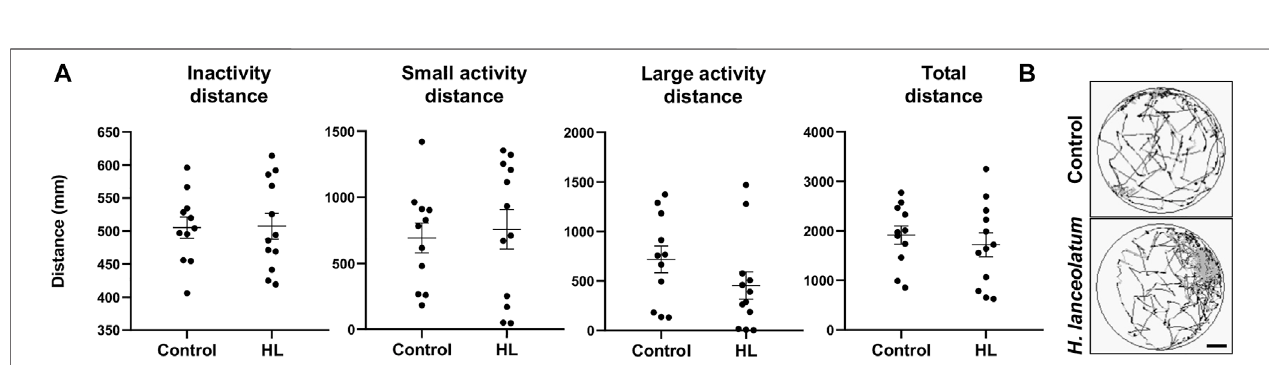
FIGURE 3 | H. lanceolatum did not impact the expression of toxicity and endocrine disruption biomarkers. (A) qPCR analysis of recognized biomarkers for hepatotoxicity ( fabp10a , gclc ), cardiotoxicity ( erg ), nephrotoxicity ( ctgf ) and glucocorticoid signaling ( fkpb5 ) of eleutheroembryos treated with H. lanceolatum aqueous extract at the MNTC (0.3125 g/L) or E3 medium (Control) for 2 days (n = 7 – 8 pools of 20 eleutheroembryos/group). (B) Fluorescence quanti fi cation of spinal cord in tg ( GFAP::GFP ) eleutheroembryos (dotted rectangle) and representative pictures of 48 h-treated eleutheroembryos (n = 35/group from 3 independent experiments). Results are expressed as means ± SEM. Bar = 200 µm.